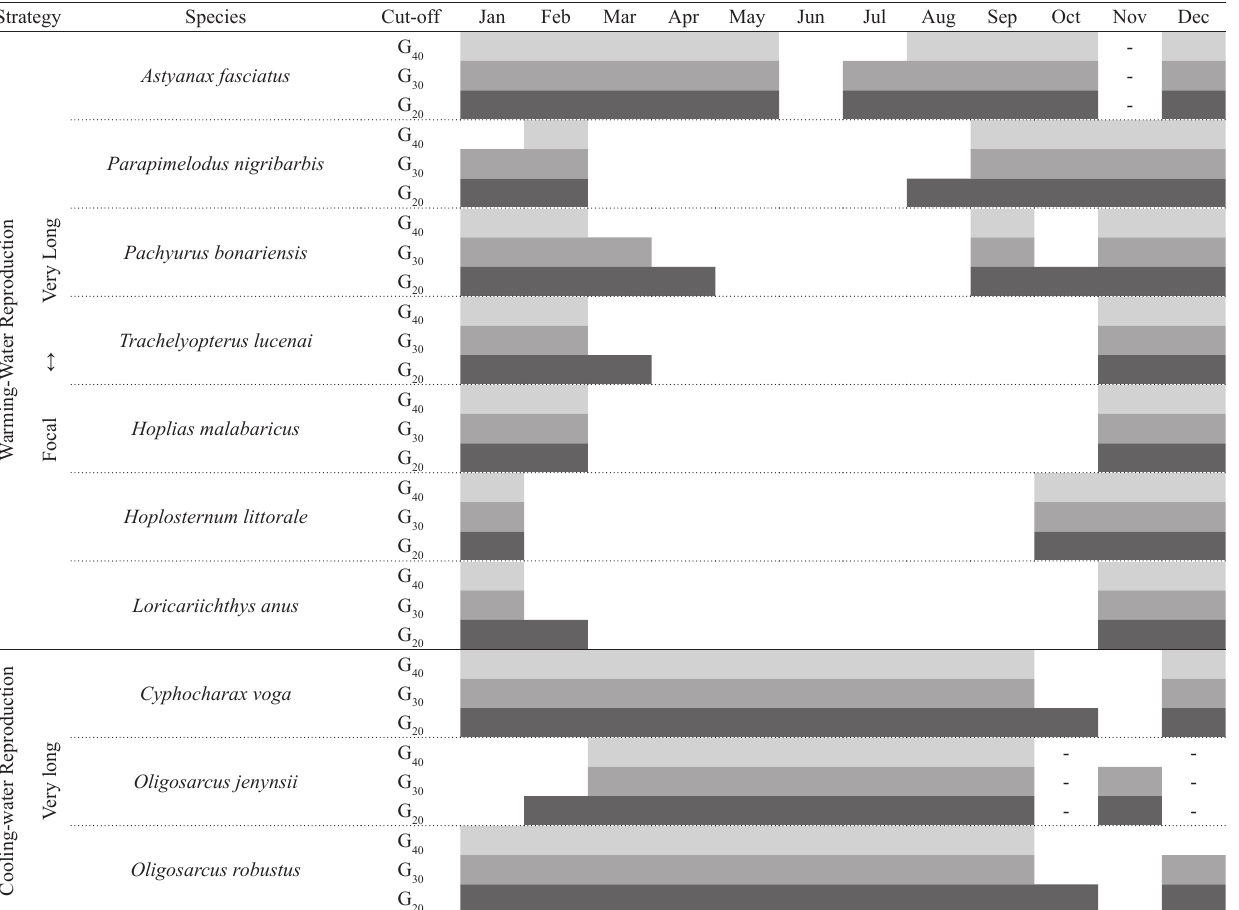
Tab. 1. Months with recorded fish reproduction based on GSI values, when at least one individual showed a GSI value equal to or greater than 20% (G ), 30% (G ) or 40% (G ) of the maximum recorded GSI value recorded for each species. Data for 20 30 40 dominant fish species in the Patos Lagoon basin (Guaíba Lake and Casamento Lake, Rio Grande do Sul,